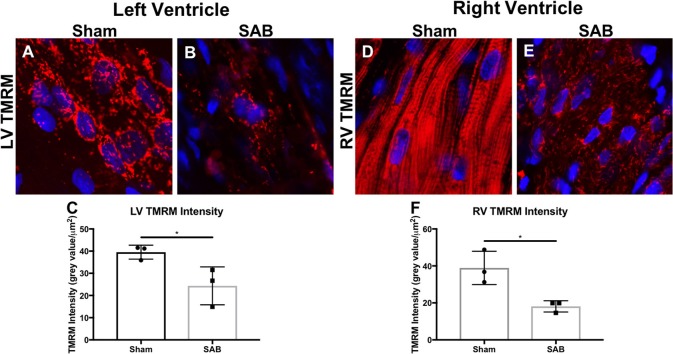
Representative confocal microscopy image showing left ventricular (LV) and right ventricular (RV) mitochondrial morphology and membrane potential of (A,D) sham rats vs. (B,E) supra-coronary aortic banding rats. The mitochondria (red) are labeled with tetramethylrhodamin, methyl ester (TMRM) and the nuclei (blue) are labeled with DAPI. (C) LV and (F) RV TMRM intensity. Each dot represents a heart from a unique rat.